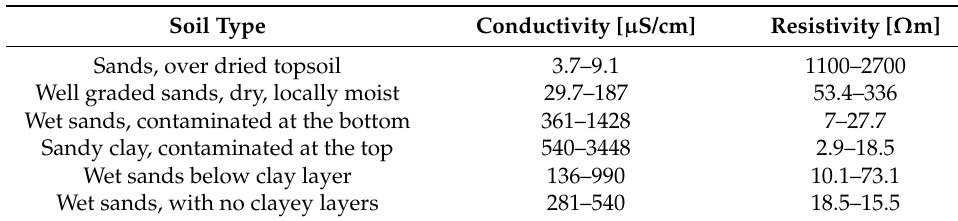
Table 2. Soil resistivity characteristics.